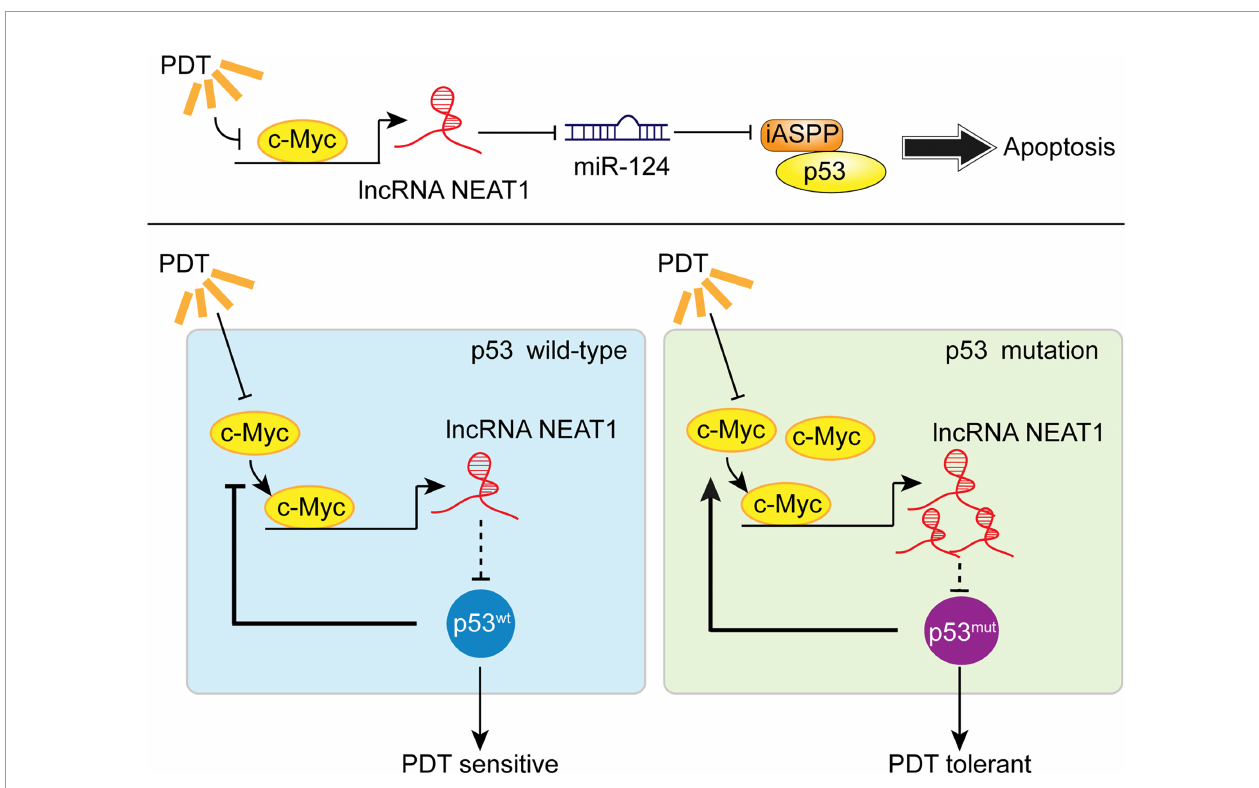
FIGURE 10 | A schematic mechanism. In p53 wt CRC cells, PDT inhibits the c-Myc/NEAT1 axis and promotes the miR-124/iASPP/p53 feedback loop that ampli fi es PDT functions, inducing cancer cell apoptosis. In p53 mut CRC cells, the expression of the c-Myc/NEAT1 axis was up-regulated, and the miR-124/iASPP/p53 feedback loop could not be activated, leading to the failure in inducing apoptosis and, thus, PDT